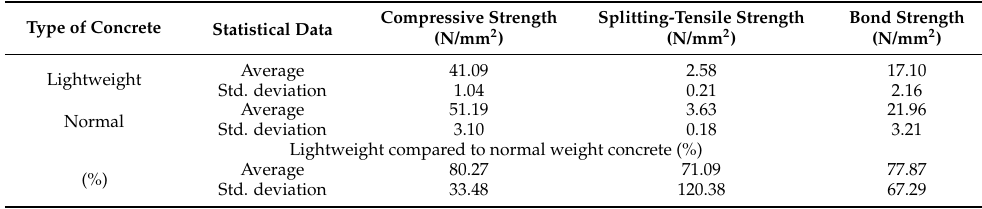
Table 7. Strengths of normal and lightweight concrete.